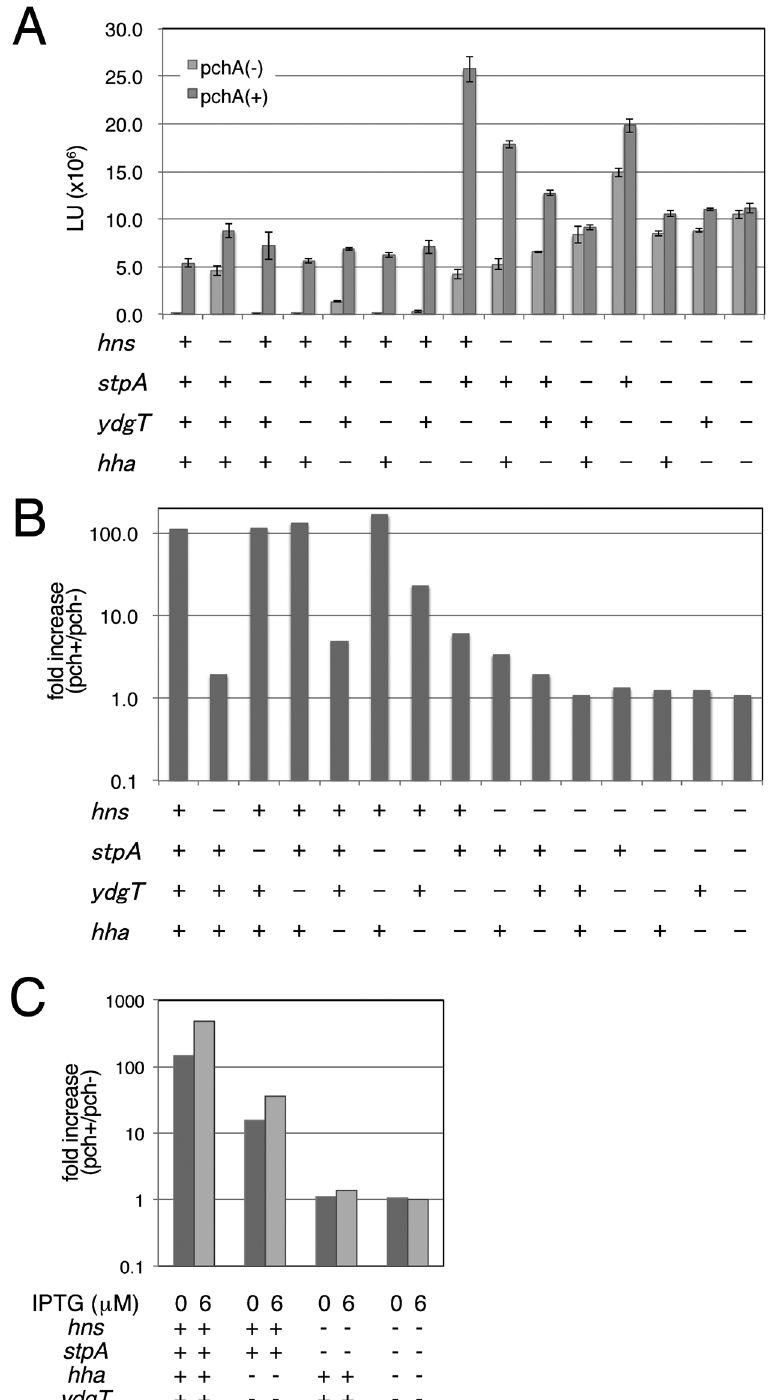
Fig 3. Activation of the LEE1 promoter by Pch in the presence or absence of H-NS and related proteins. A. Effect of Pch on LEE1 promoter activity in deletion mutants of hns and its homolog and paralog genes. W3110 and its derivative mutants harboring pLux-P LEE1 and pTB101 (-) or pTB101- pchA (+) were grown in LB. Luciferase activity was measured when the OD 600 reached approximately 2.0, and the luciferase value was normalized by the OD 600 . B. Activation by Pch in the mutants. The activation rate in each strain was deduced from the experiments in A. C. Loss of dose-dependent activation. Bacteria were grown